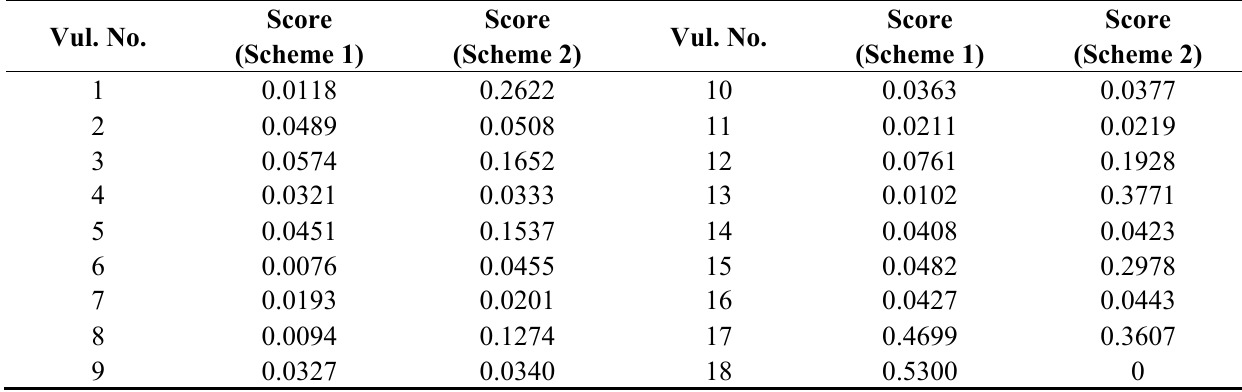
Table 6. Quantitative results of vulnerabilities in different